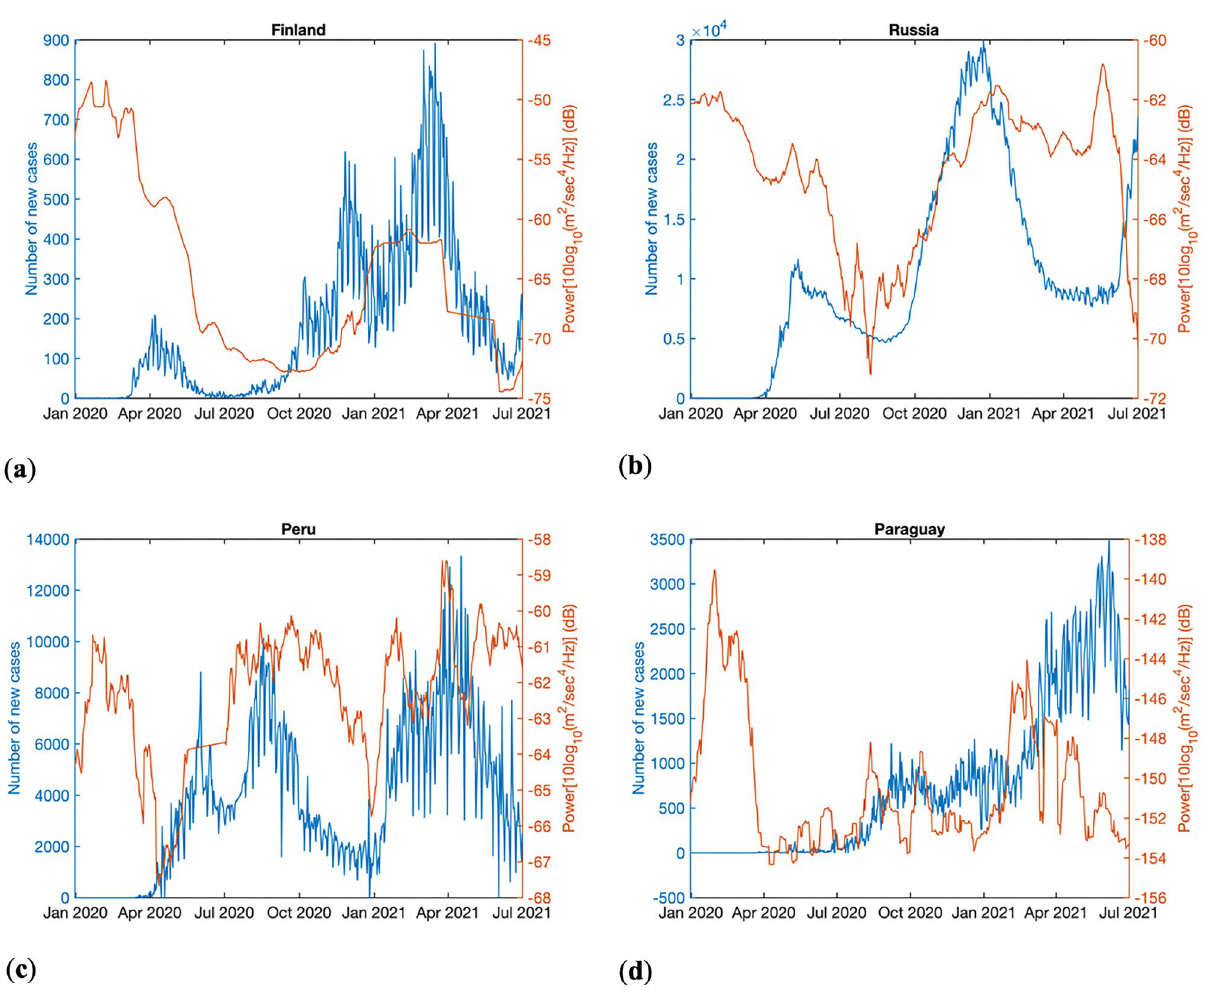
Figure 3. Correlation between second wave of peak in new cases and increasing in seismic noise (easing of lockdowns) for ( a ) Finland ( b ) Russia ( c ) Peru ( d )